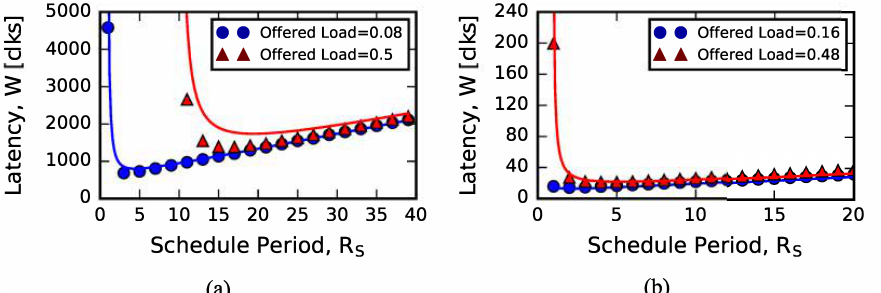
Figure 11. Discrete-event simulation of latency vs. schedule period for the M/G/1 queueing model. The curves are analytically generated from (18) and the points are empirically measured via the discrete-event simulation. ( a ) C = 10, N = 100, S = 100 ( b ) C = 4, N = 8, S = 4.